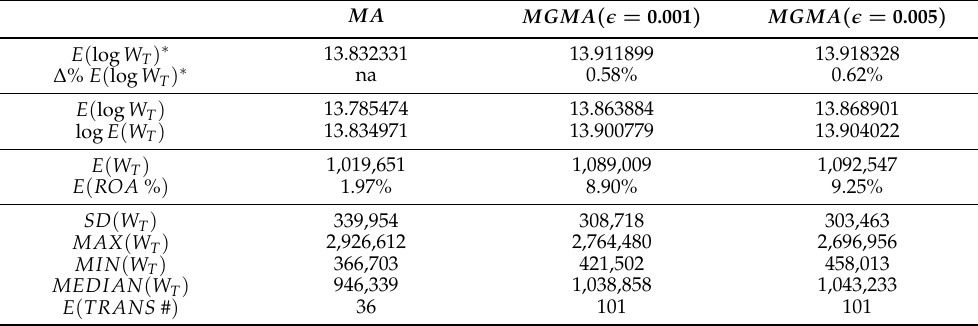
Table 6. MGMA strategy performance summary for scenario 1 on the simulated three-asset portfolio (1000 run; s = 5; l = 30).